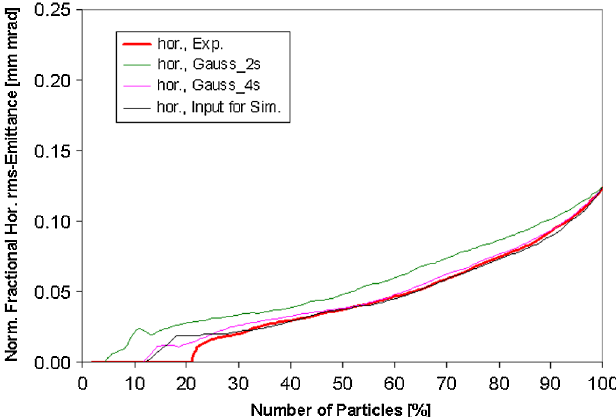
FIG. 7. (Color) Brilliance curves of the horizontal phase space distribution in front of the DTL. The curves were extracted from the measured distribution (red bold), a Gaussian cut at 2 (cid:4) (green), a Gaussian cut at 4 (cid:4) (pink), and from the distribution used for the simulations (black).